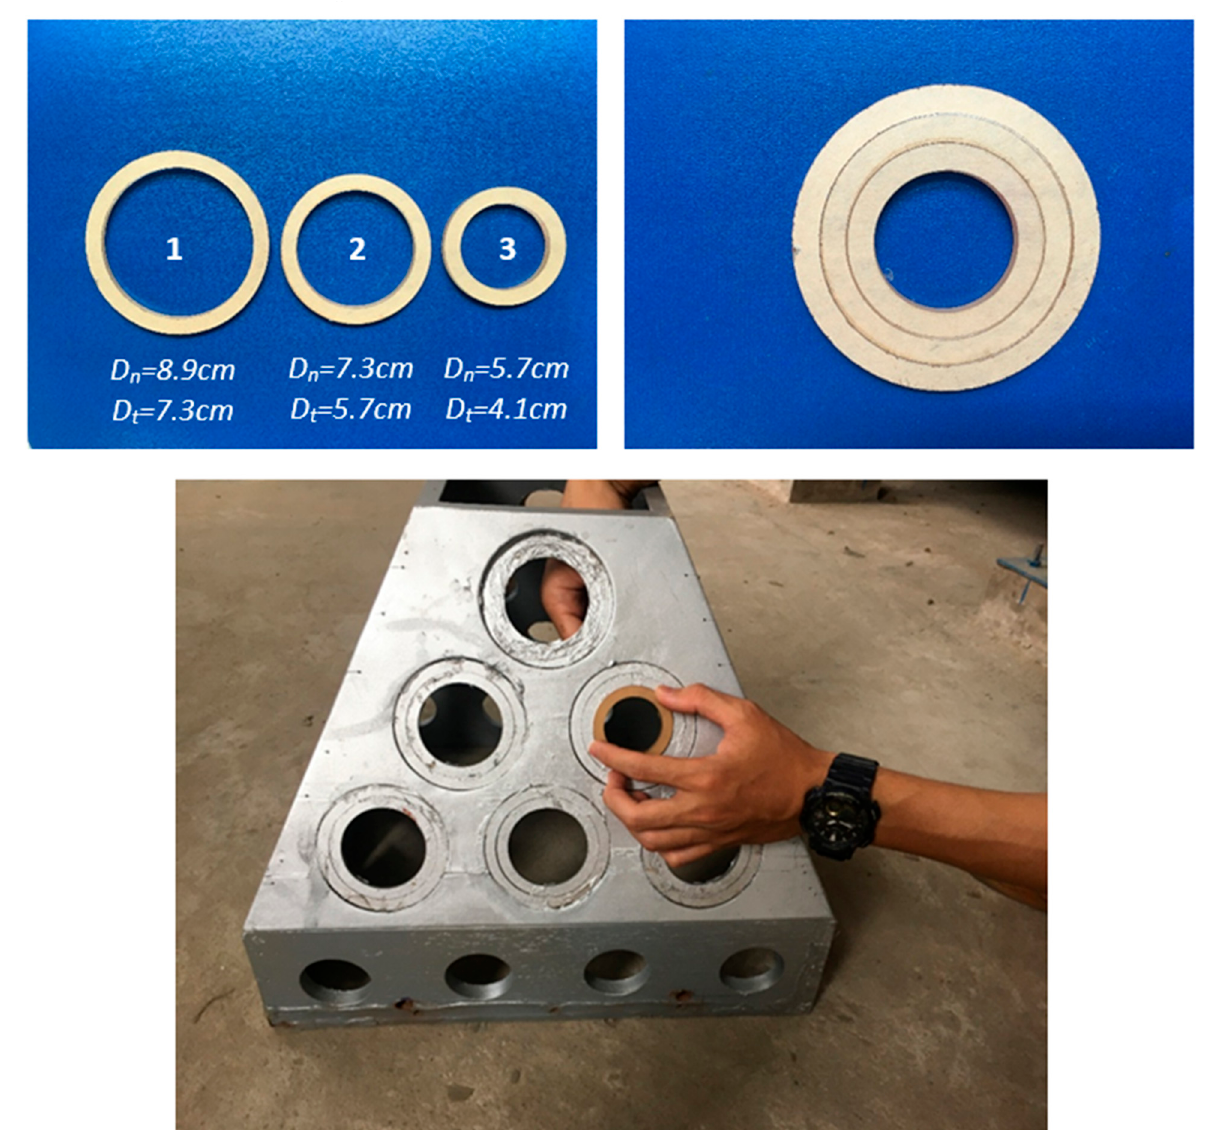
Figure 10. Sizes of the rings composing the pore in the model block ( D o —outer diameter; D i —inner diameter). 1—Outer and inner rings for pore emulation in the breakwater. 2—Rings are combined together to achive the necessary pore diameter. 3—Putting the combined rings to the breakwater phisical